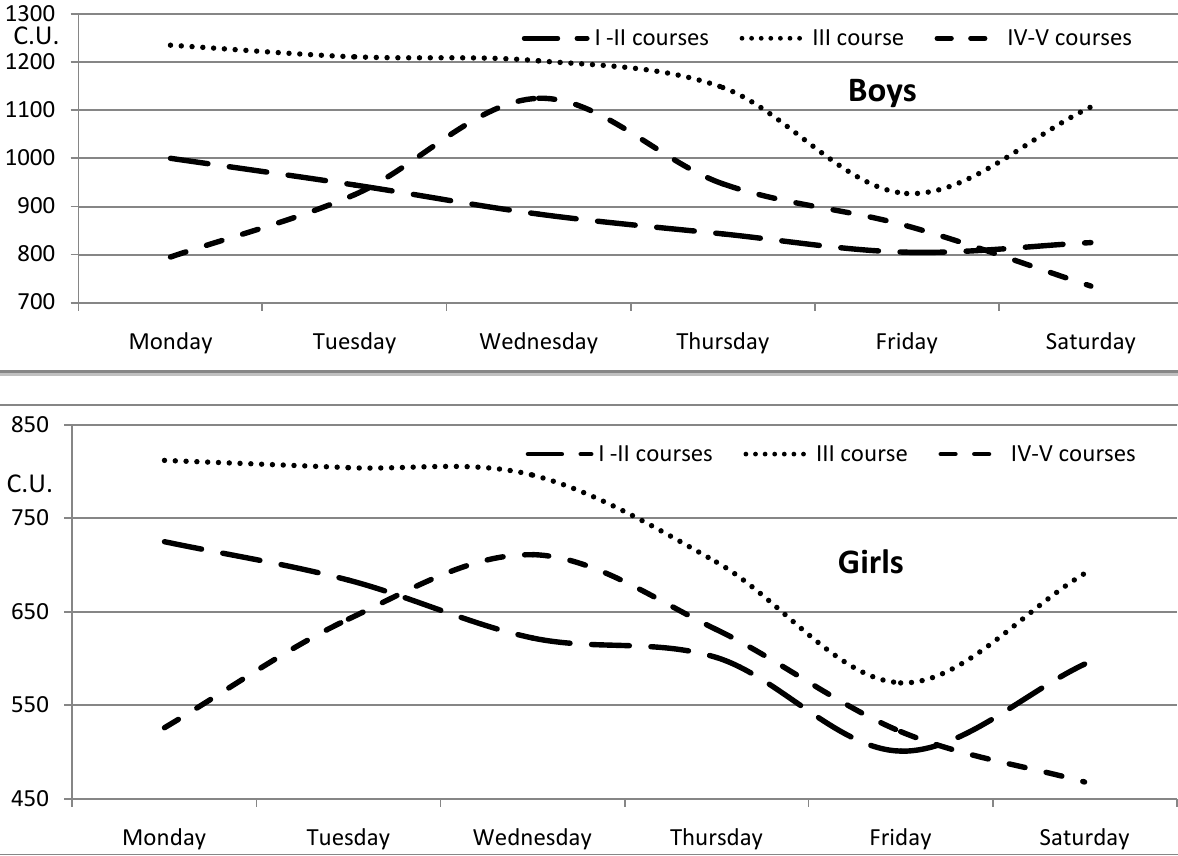
Fig. 1. The Dynamics of the level of manifestation of physical work capacity among students during a weekly training